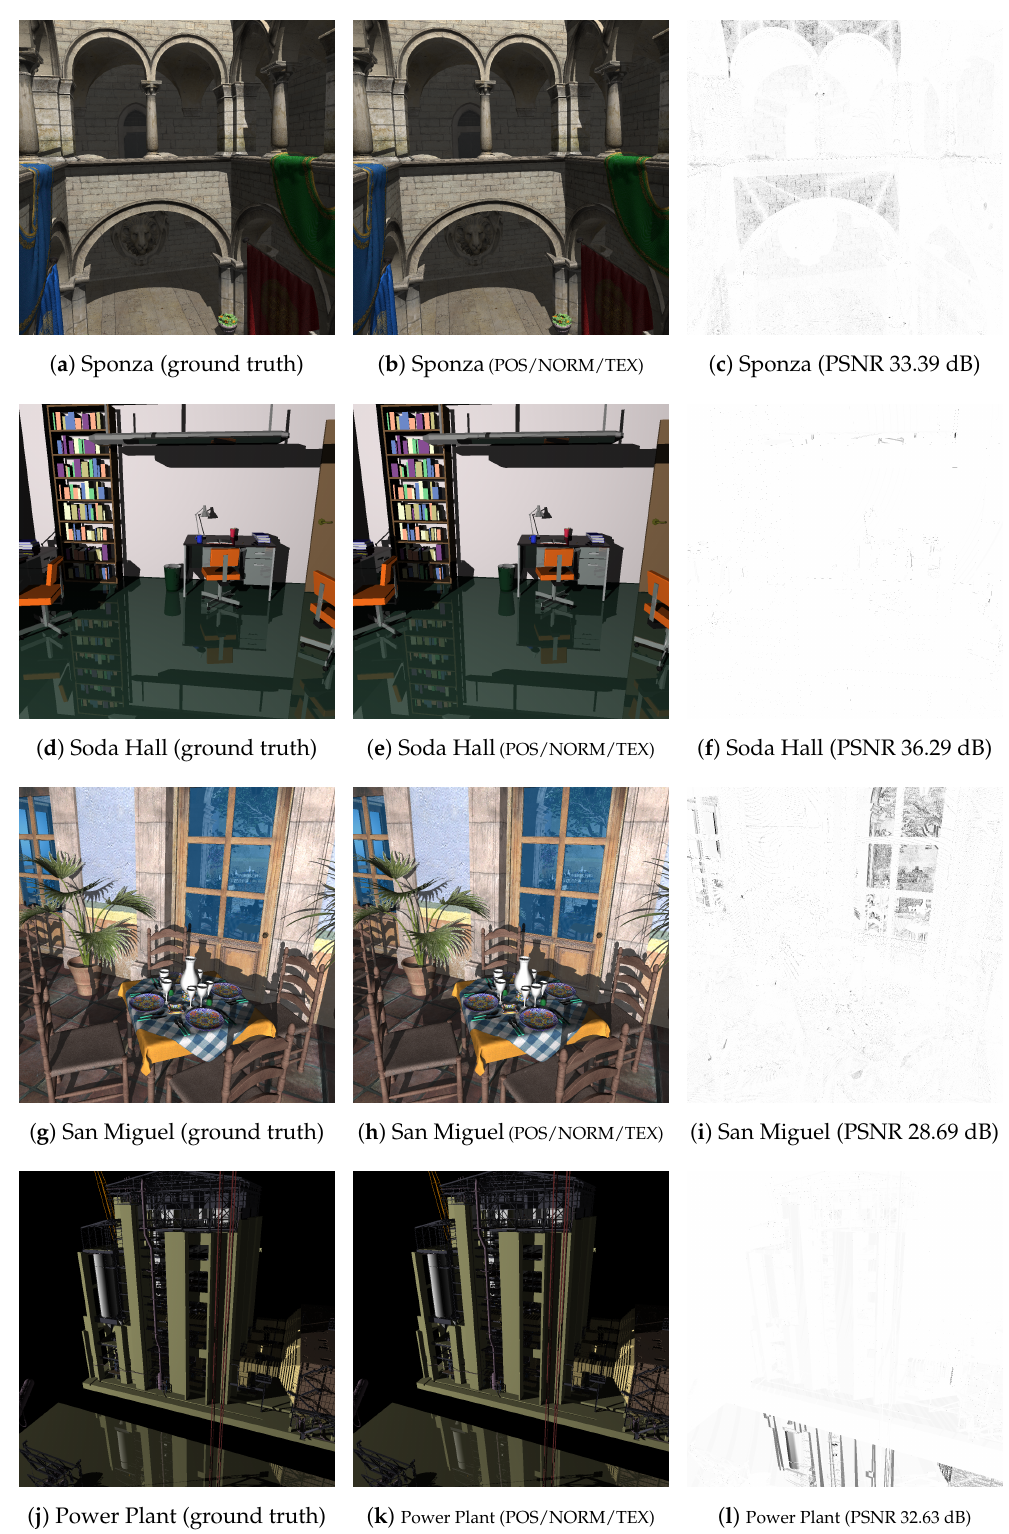
Figure 2. Comparison with ground truths. The left and middle columns display the images rendered by ray tracing the original and quantized triangular meshes, respectively. The right column then shows their differences with achieved PSNR